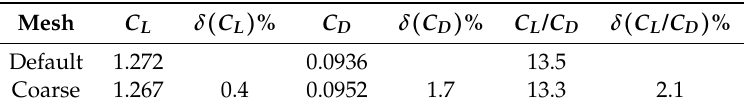
Table 5. Sensitivity study on mesh resolution for Re = 10 4 and AoA = 8 ◦ . Default correspond to a mesh with ≈ 6 × 10 6 cells, coarse corresponds to a mesh with ≈ 3 × 10 6 cells. δ is the relative difference with the default mesh resolution case.